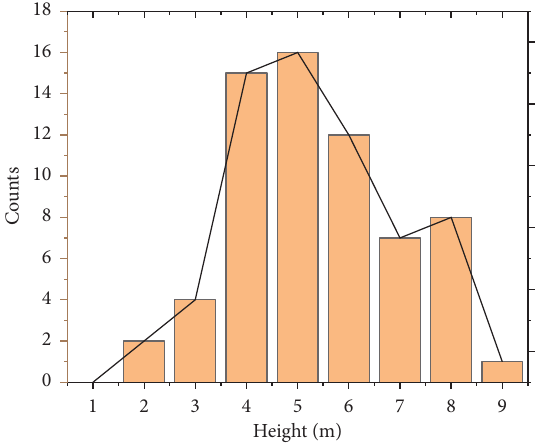
Figure 6: Height (m) class distribution.